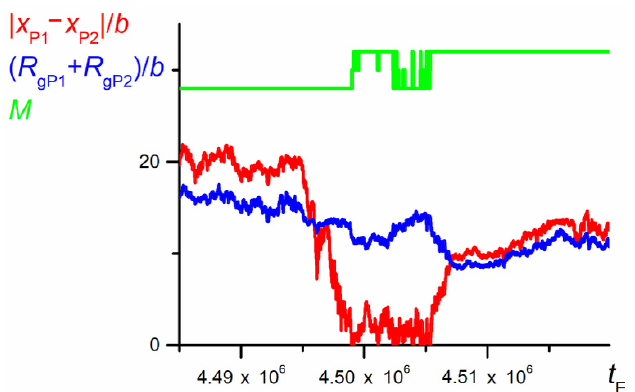
Figure 13. The distance between mass centers of P1 and P2 and the sum of their radii of gyration for the fragment of trajectory from Figure 12 ( N = 100, ε PP / k B T = − 1 and 0 for P1 and P2, respectively, D = 3 b ). The chart is based on the data recorded at each elementary step.